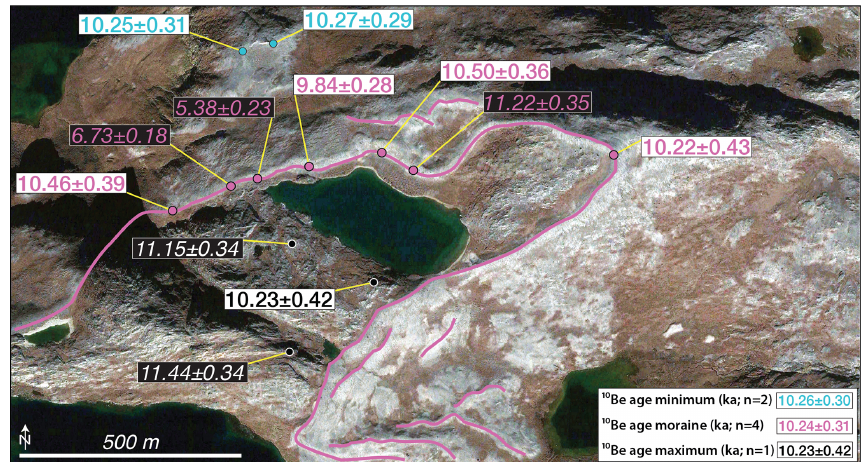
Figure 7. Kapisigdlit stade moraine located just west of KNS (Fig. 2). 10 Be ages (ka ± 1SD) are from three morphostratigraphic groups: (1) outboard of the moraine (black text and symbols), (2) moraine boulders (pink text and symbols), and (3) inside the moraine (blue text and symbols). 10 Be ages that are considered outliers are in black boxes with italics. Map data: © Google Maps, Maxar Technologies.